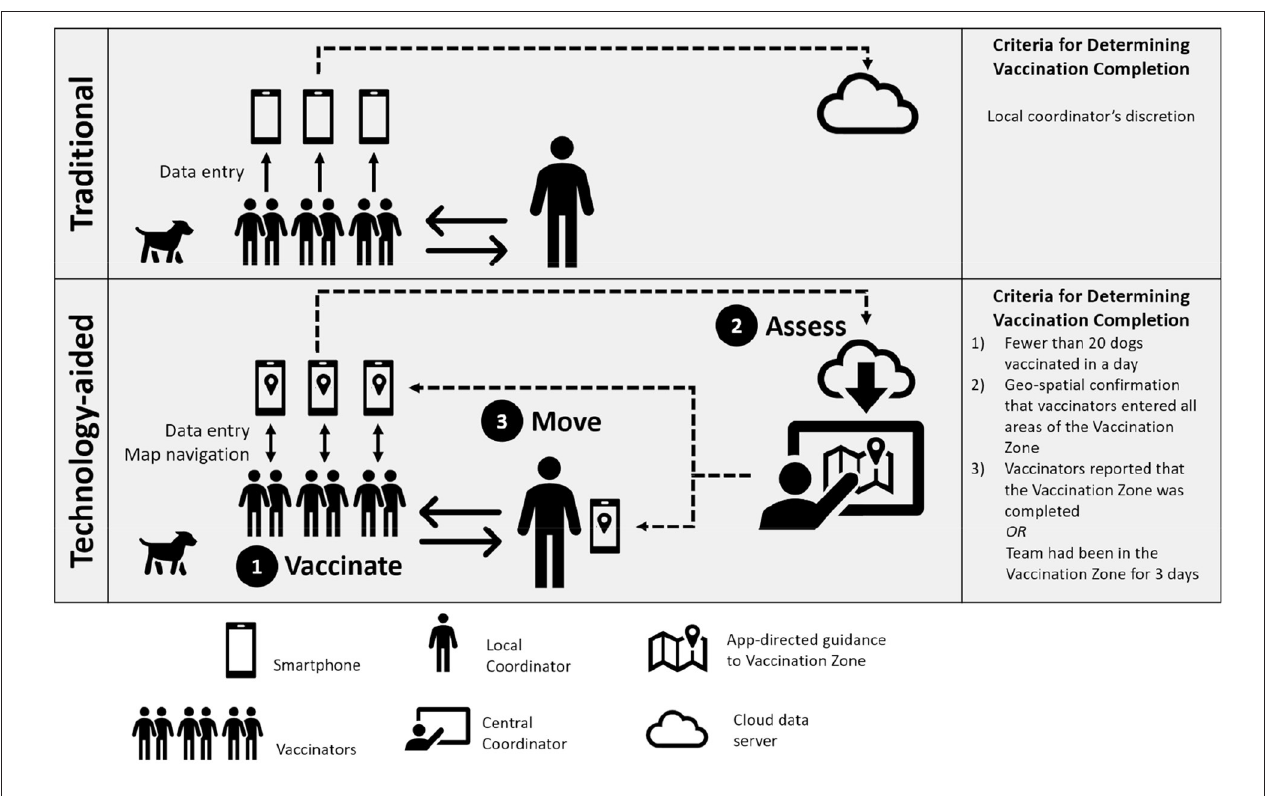
FIGURE 2 | Illustration of the Traditional and Technology-aided methods of campaign management evaluated in the study, including the criteria for guiding team direction by